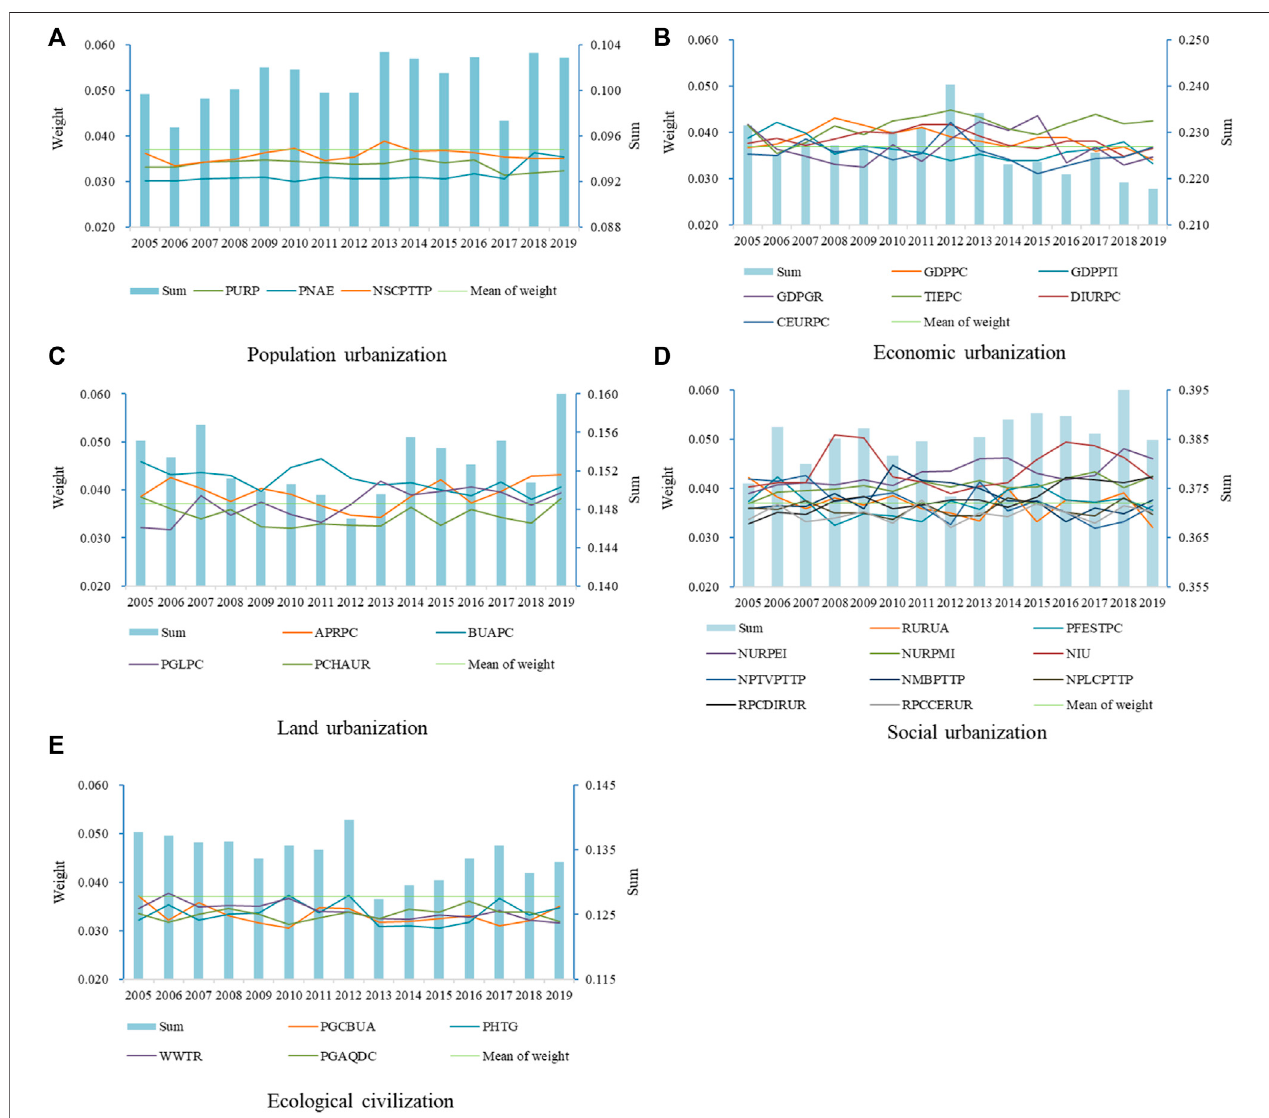
FIGURE 3 | Weights of each index over the years. (A) Population urbanization. (B) Economic urbanization. (C) Land urbanization. (D) Social urbanization. (E) Ecological civilization.